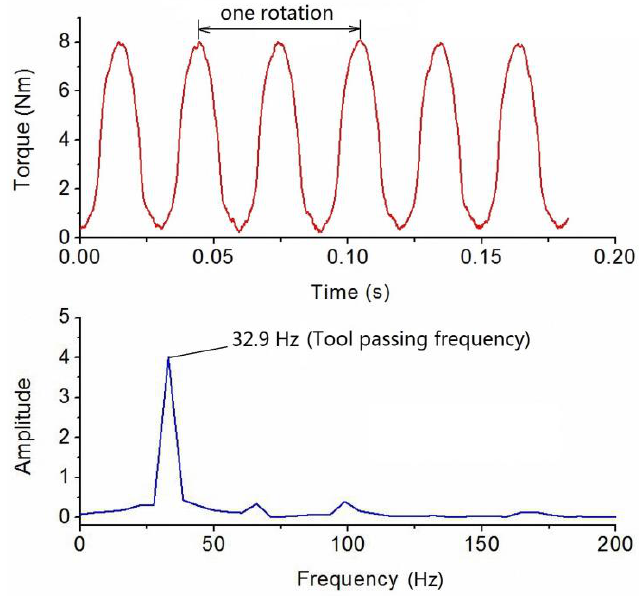
Figure 13. Plots of torque force signals in time and frequency domain at a spindle speed of 1000 rpm.